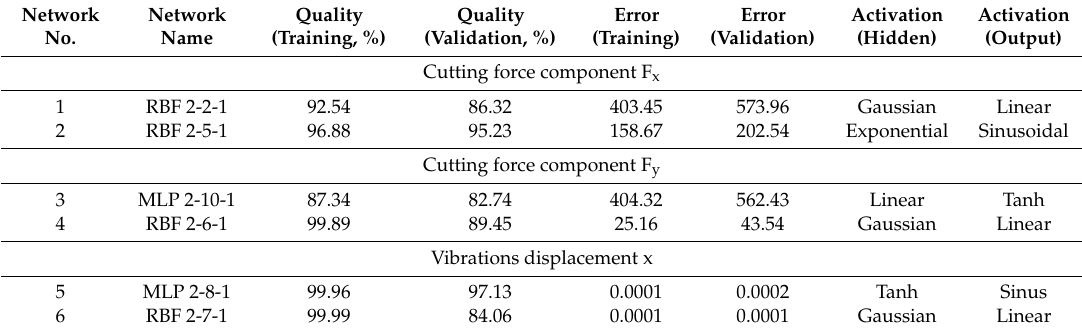
Table 4. Characteristics of multilayered perceptron (MLP) and radial basis function (RBF) networks for the cutting force components Fx, Fy and vibrations displacement x for AZ31 alloy. Network